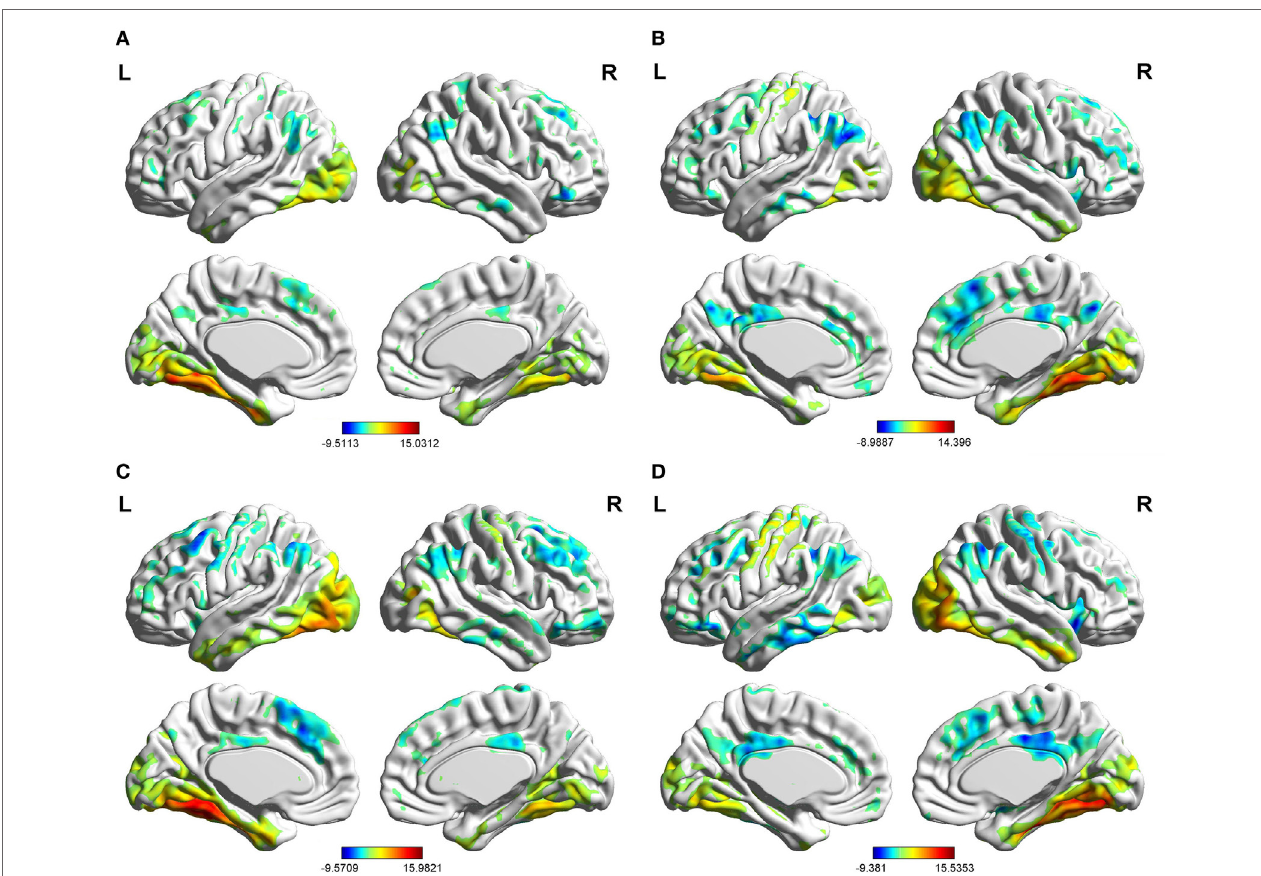
fusiform gyrus; (B) control group in the right fusiform gyrus; (c) aMCI group in the left fusiform gyrus; (D) aMCI group in the right fusiform gyrus.